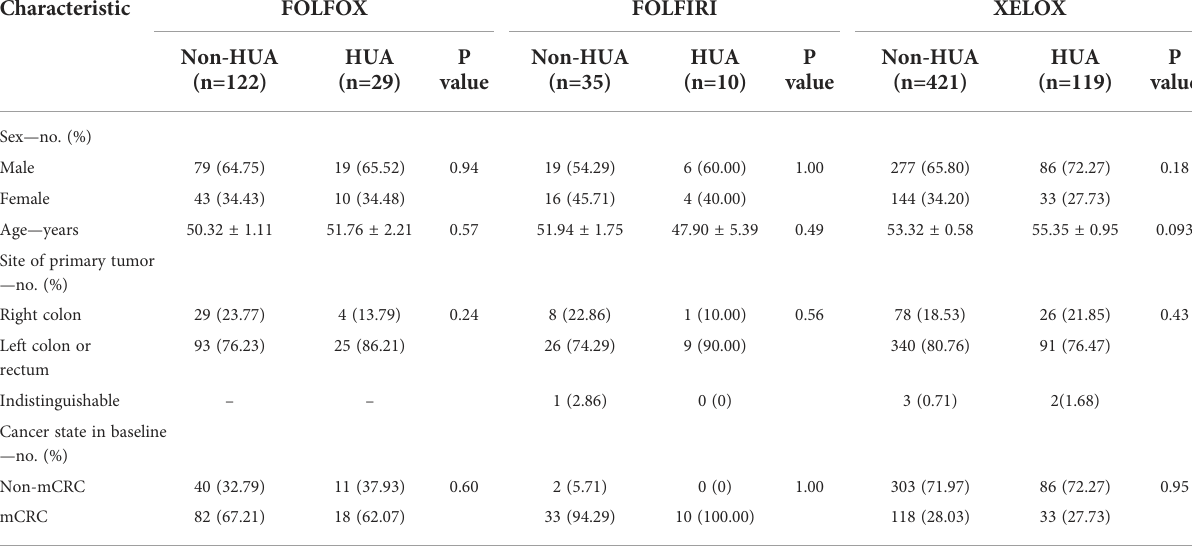
Table 1 Baseline characteristics of colorectal cancer patients treated with postoperative chemotherapy. Characteristic FOLFOX FOLFIRI XELOX Non-HUA